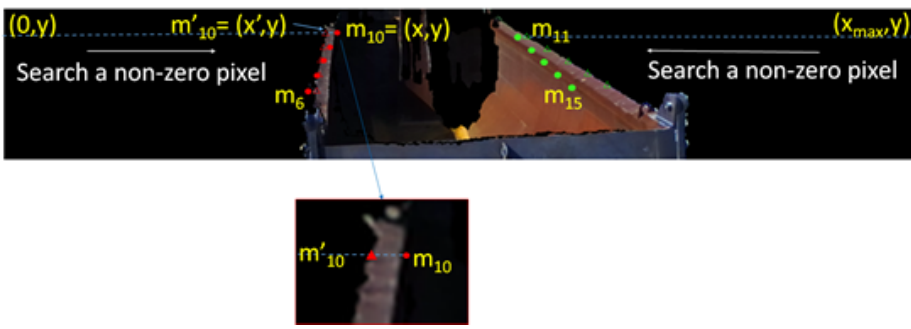
Figure 16. Example of the 3D points of a 3D model projected onto a 2D image of the camera.